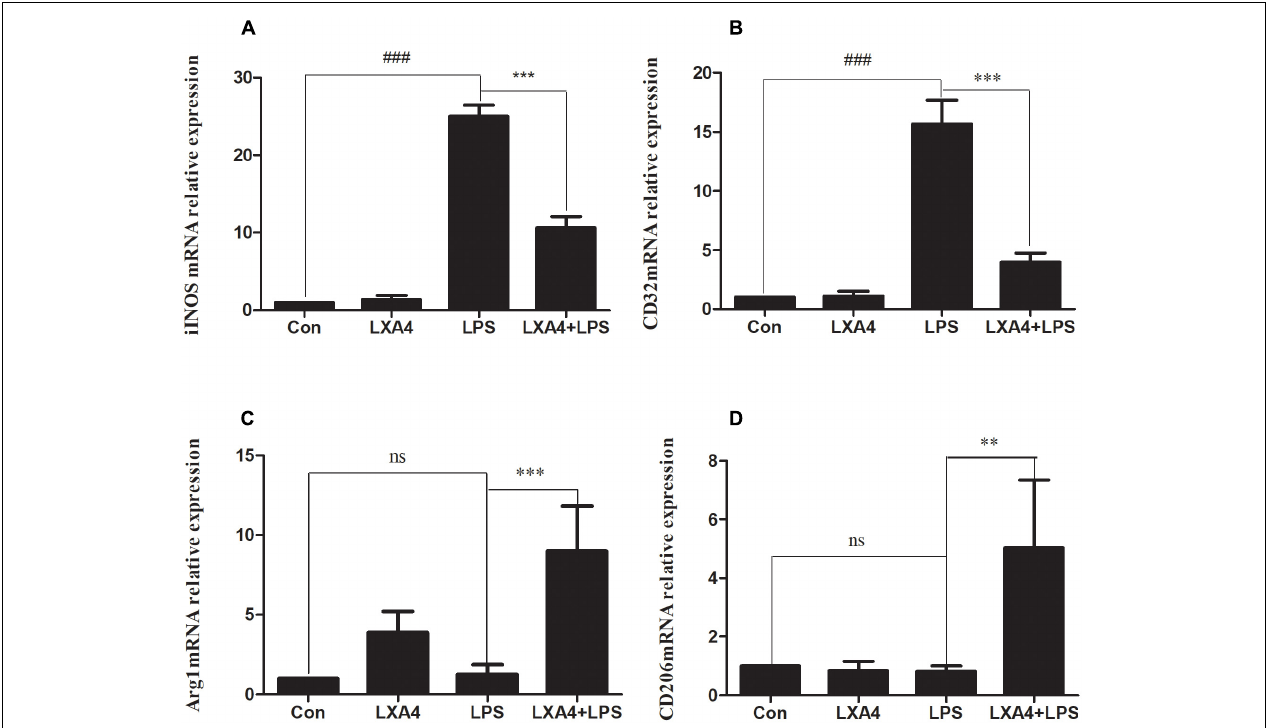
FIGURE 2 | Quantitative RT-PCR analysis of iNOS, CD32, Arg1, CD206 mRNA levels in the BV2microglia 6 h after LPS treatment. (A,B) Quantitative RT-PCR analysis of iNOS, CD32 mRNA levels. (C,D) Quantitative RT-PCR analysis of Arg1, CD206 mRNA levels. LPS upregluated M1 microglia biomarkers iNOS, CD32. With LXA4 intervention, iNOS, CD32 expression decreased, M2 microglia biomarkers Arg1, CD206 expression increased significantly. ## , ∗∗ p < 0.01; ### , ∗∗∗ p < 0.001; n.s., no significance.